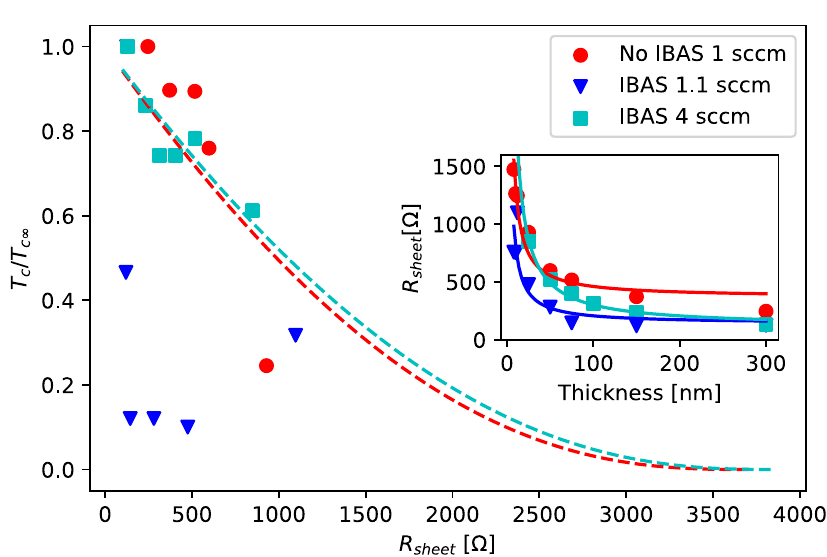
Figure 6. Dependence of superconducting T c on sheet resistance. The 1 sccm non-IBAS (red), 1.1 sccm (blue) and 4 sccm (cyan) IBAS films are shown. The red and cyan curves are experimental fits of the data to Eq. (6). The blue 1 sccm IBAS data does not follow the same model. Inset: dependence of sheet resistance on film 1 thickness where all three curves follow a similar d